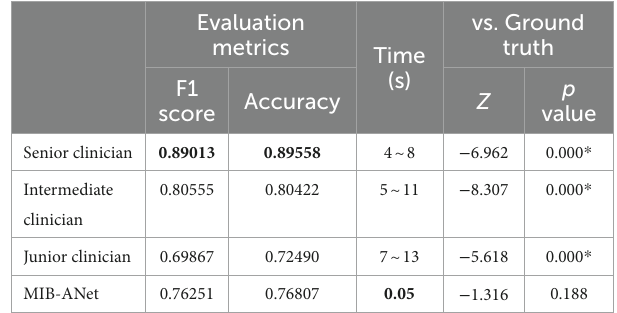
TABLE 2 Performance of MIB-ANet to E.N.T. clinicians.